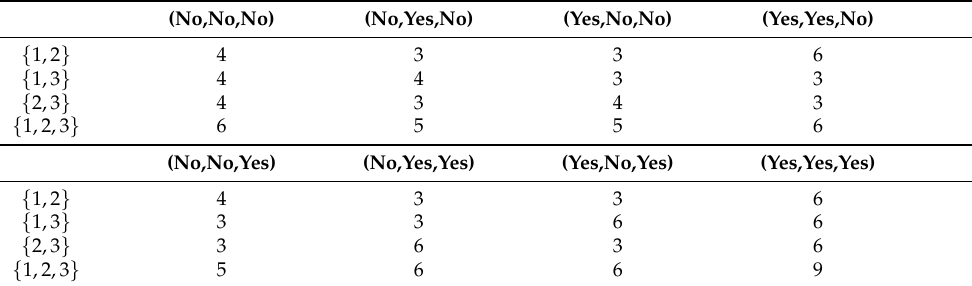
Table 5. Coalitions’ utilities of a coordination game.